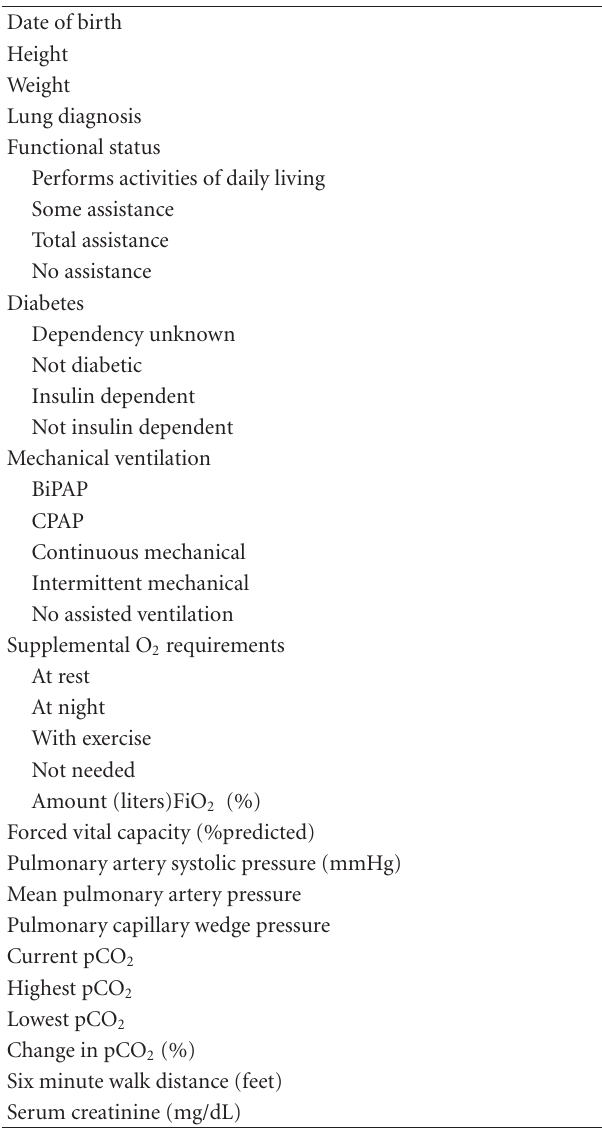
Table 1: Components of the Lung Allocation